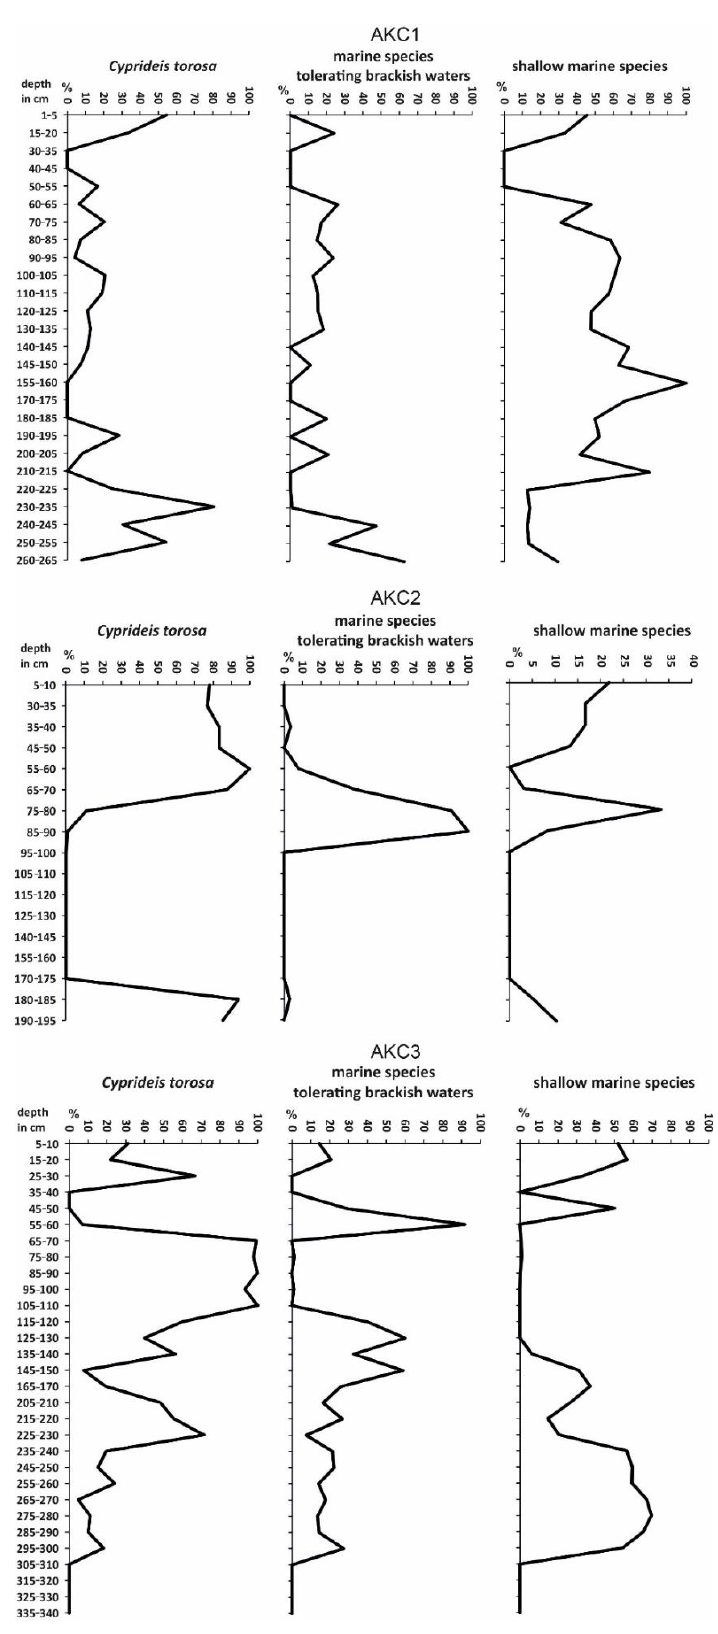
Figure 4. Distribution of ostracod assemblages along the cores. Marine species tolerating brackish waters: B. berchoni, X. communis , A. woodwardii. Shallow marine species: species of the genera Loxoconcha , Phlyctenophora , Xestoleberis , Semicytherura , Pontocythere, Leptocythere and Urocythereis .